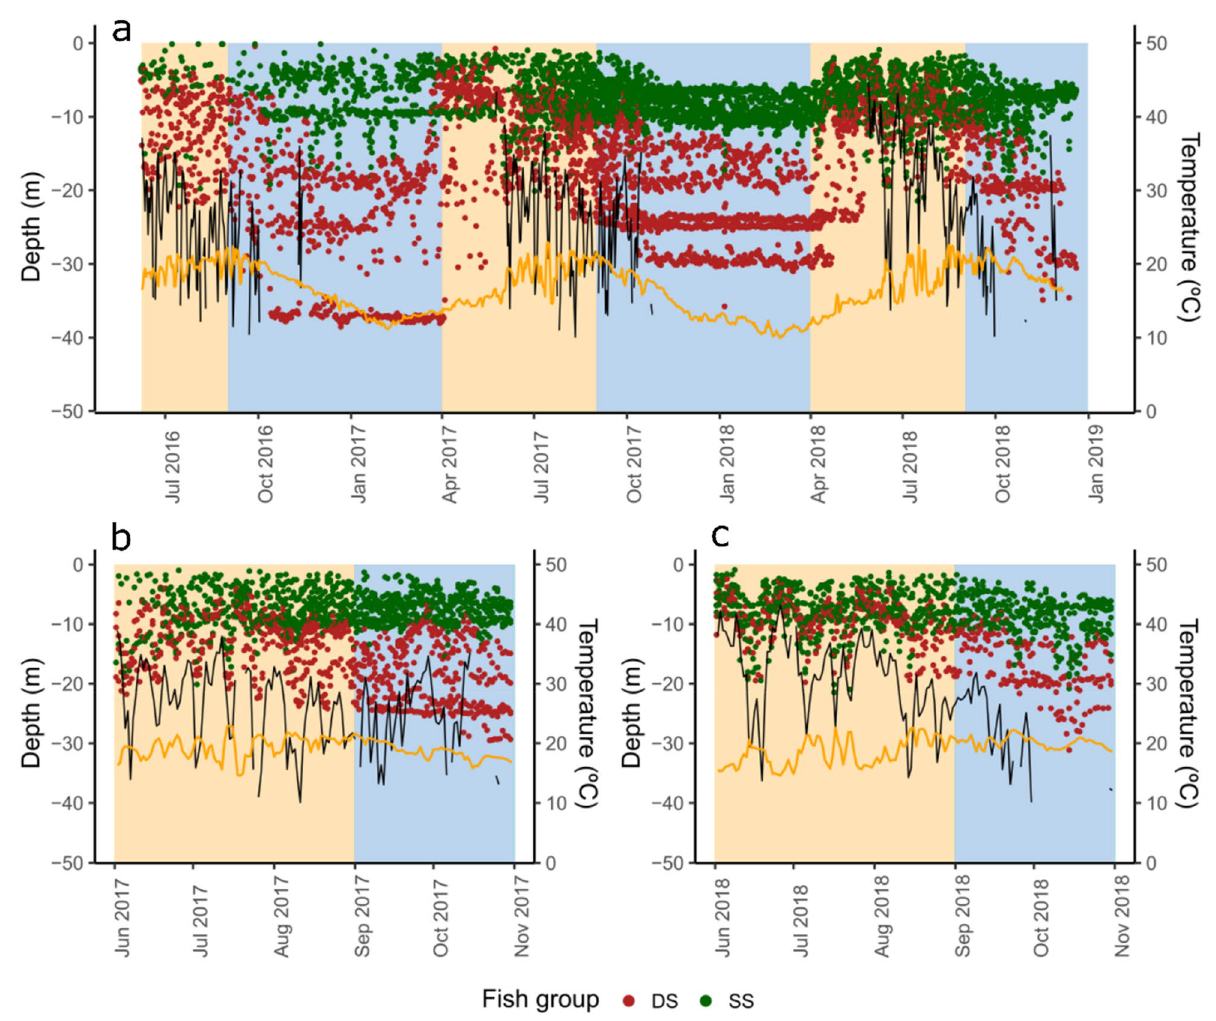
Figure 6. Fish depth over the study period. Points represent the daily mean depth of all fish identified by group ( SS shallow/shallow in green, DS deep/shallow in red), over the whole study period ( a ) and a subset of data when the thermocline is present in 2017 ( b ) and 2018 ( c ). Black lines represent thermocline depth and orange lines represent temperature (°C) at 15 m depth. Background colors represent cold and warm periods in blue and light orange,